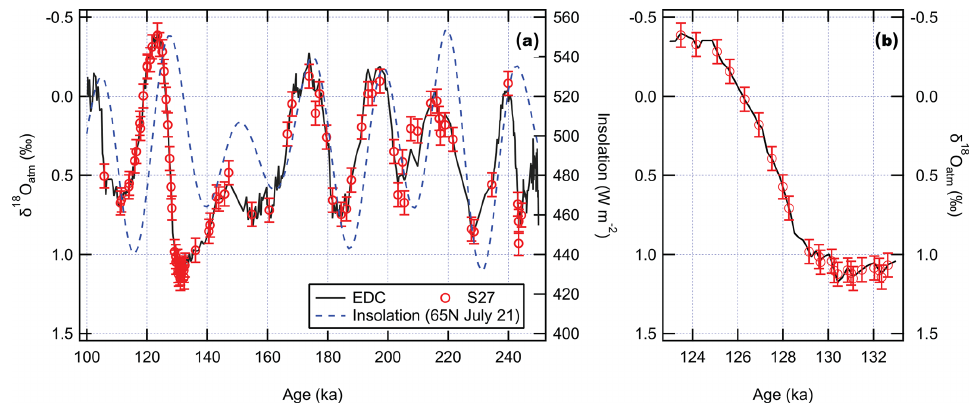
Figure 4. δ 18 O atm measured in S27 (red) was matched to a high-resolution δ 18 O atm record from EDC (black) between 100 and 250ka by Extier et al. (2018): (a) the whole record between 114 and 255ka, accompanied by the Northern Hemisphere (65 ◦ N) 21 July insolation curve (dashed blue), and (b) a close-up view between 123 and 133ka. S27 δ 18 O atm data include those reported in Spaulding et al. (2013) and additional δ 18 O atm samples measured in this work. Error bars represent 95% confidence interval of the combined EDC and S27 δ 18 O atm measurements, following the approaches described in the Supplement.